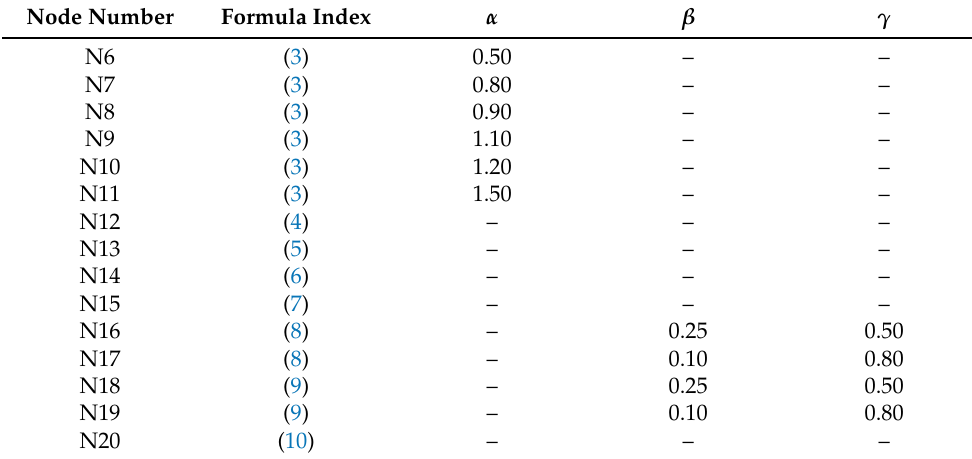
Table 2. Originally designed processing nodes of 15